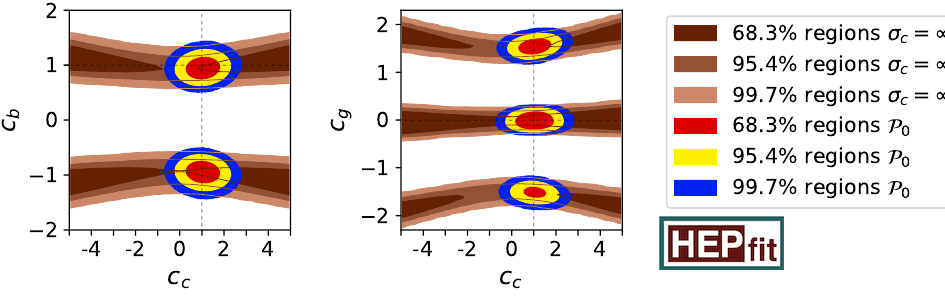
Figure 2 . Constraints on the c b vs. c c (left) and c g vs. c c (right) planes obtained from a (cid:12)t using a (cid:13)at prior ( (cid:27) c = 1 ) within [ (cid:0) 5 ; 5] for c c (brown regions) and the same assuming a Gaussian prior for c c with (cid:27) c = 0 : 5. Both (cid:12)ts use the same experimental data. While the (cid:12)t with a Gaussian prior for c c is concentrated around the SM limit, denoted by the black dashed lines, in the (cid:13)at case the posterior for all parameters is signi(cid:12)cantly broadened and also shows a tendency towards larger values for all parameters c i